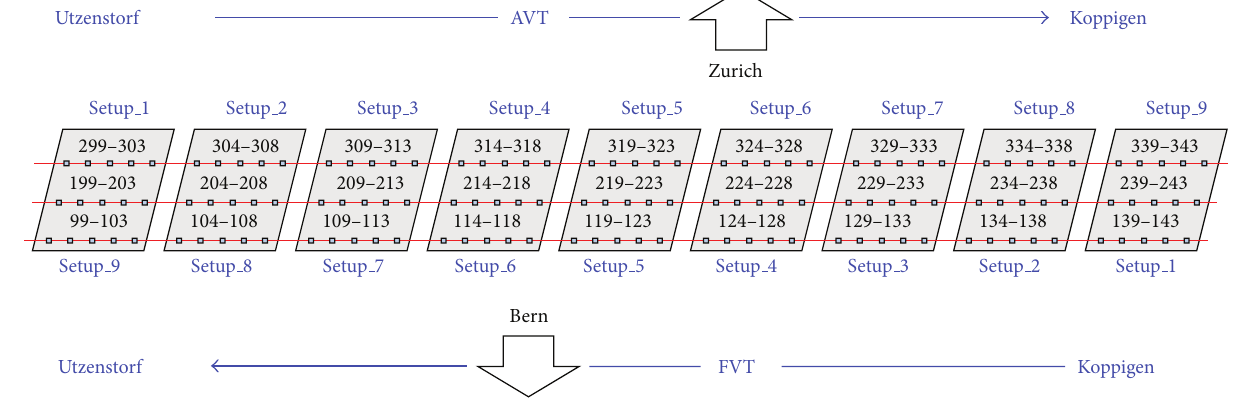
Figure 1: Measurement setup for vibration test on Z24 bridge [26].